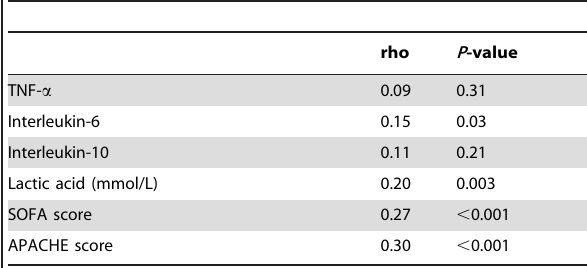
Table 3. Correlation of serum caspase-cleaved citokeratin (CCCK)-18 levels with serum levels of TNF- a , interleukin-6, interleukin-10, and lactic acid, and with SOFA and APACHE-II scores.